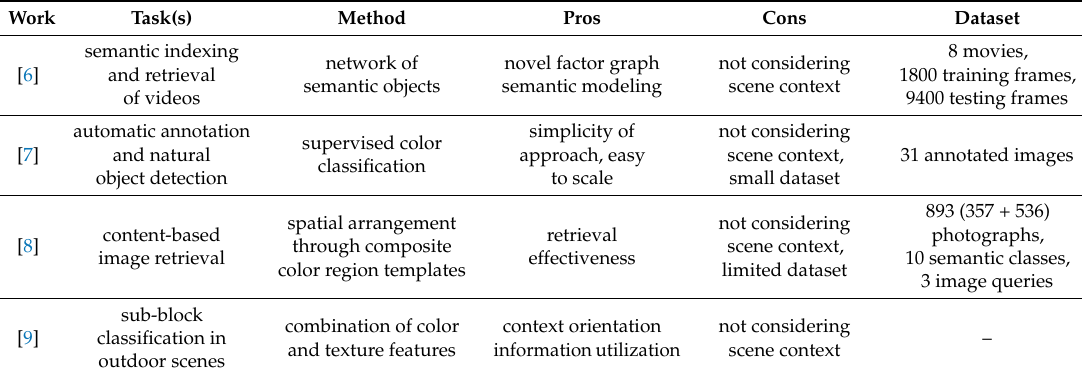
Table 1. Low-level visual context